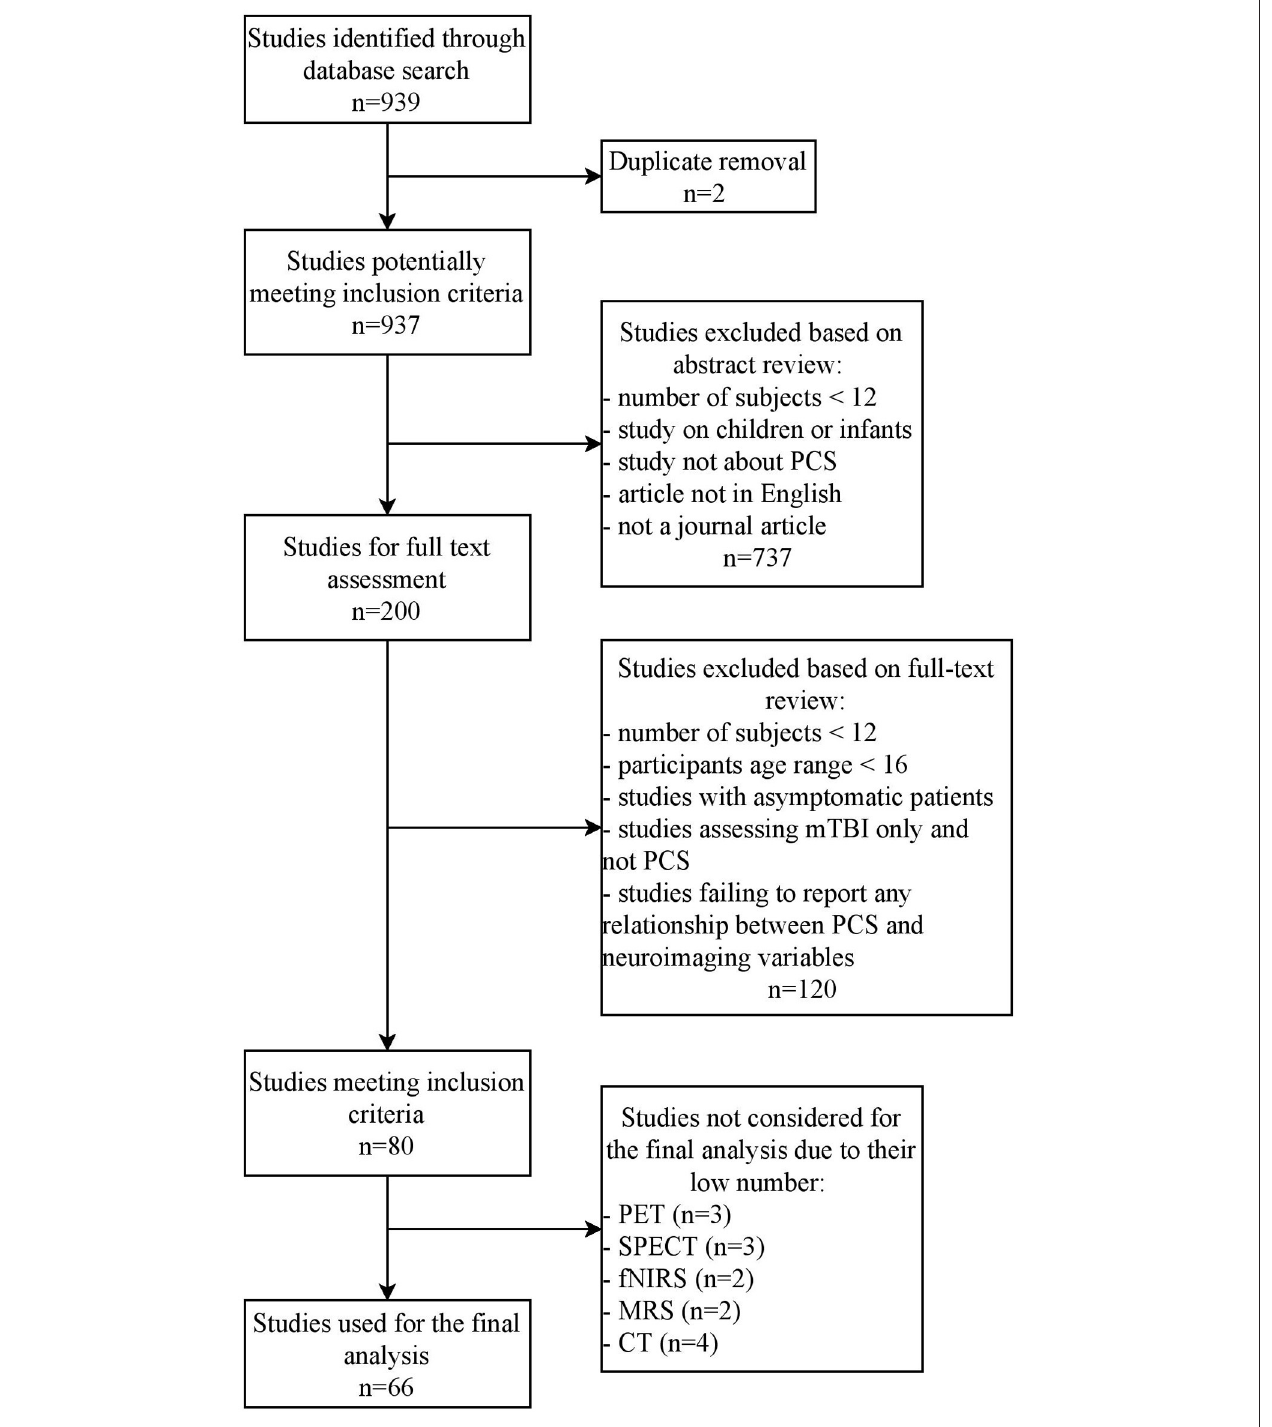
FIGURE 1 | PRISMA flowchart. A search over the Pubmed database yielded 939 studies, after which they were screened in the first round based on their abstracts and in the second round based on the main text of the remaining studies (PET, Positron Emission Tomography; SPECT, Single Photon Emission Computed Tomography; fNIRS, Functional Near Infrared Spectroscopy; MRS, Magnetic Resonance Spectroscopy; CT, Computed Tomography).